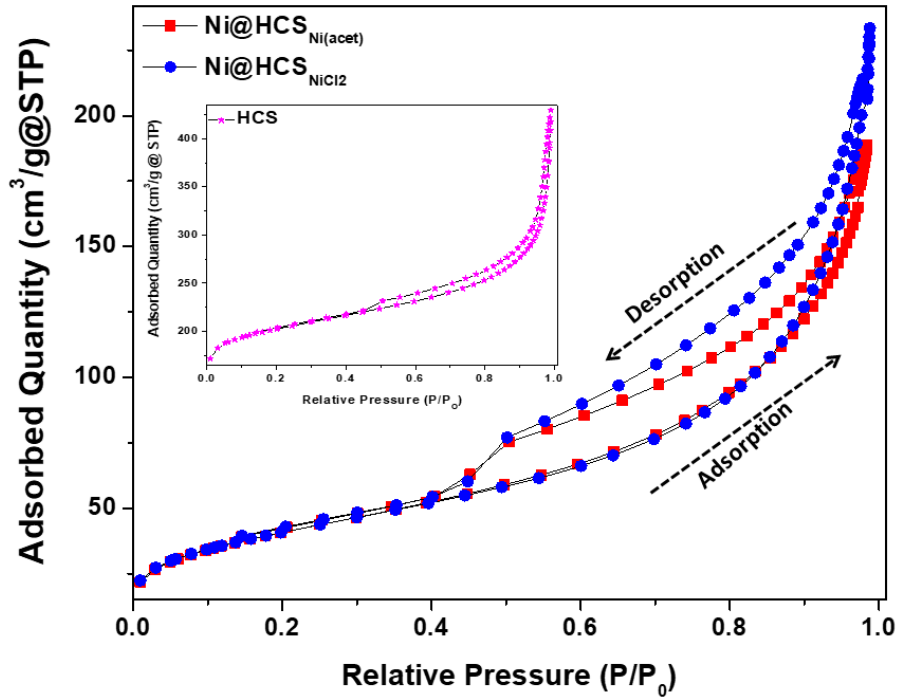
Figure 3: Adsorption isotherms of the Ni@HCSs nanocatalysts. Insert: Adsorption isotherms of pristine HCSs.